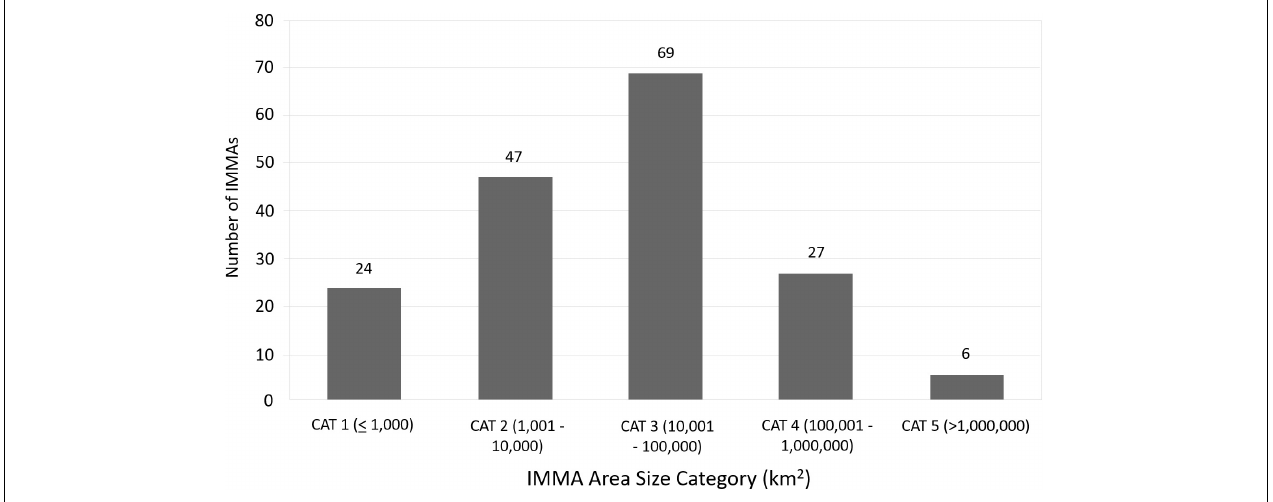
FIGURE 4 | The frequency of IMMA area size categories observed across the IMMA Network where CAT 1 ( ≤ 1,000 km 2 ) = 14% of total area; CAT 2 (1001 – 10,000 km 2 ) = 27% of total area; CAT 3 (10,001 – 100,000 km 2 ) = 39% of total area; CAT 4 (100,001 – 1,000,000 km 2 ) = 15% of total area; CAT 5 ( > 1,000,001 km 2 ) = 6% of total area.